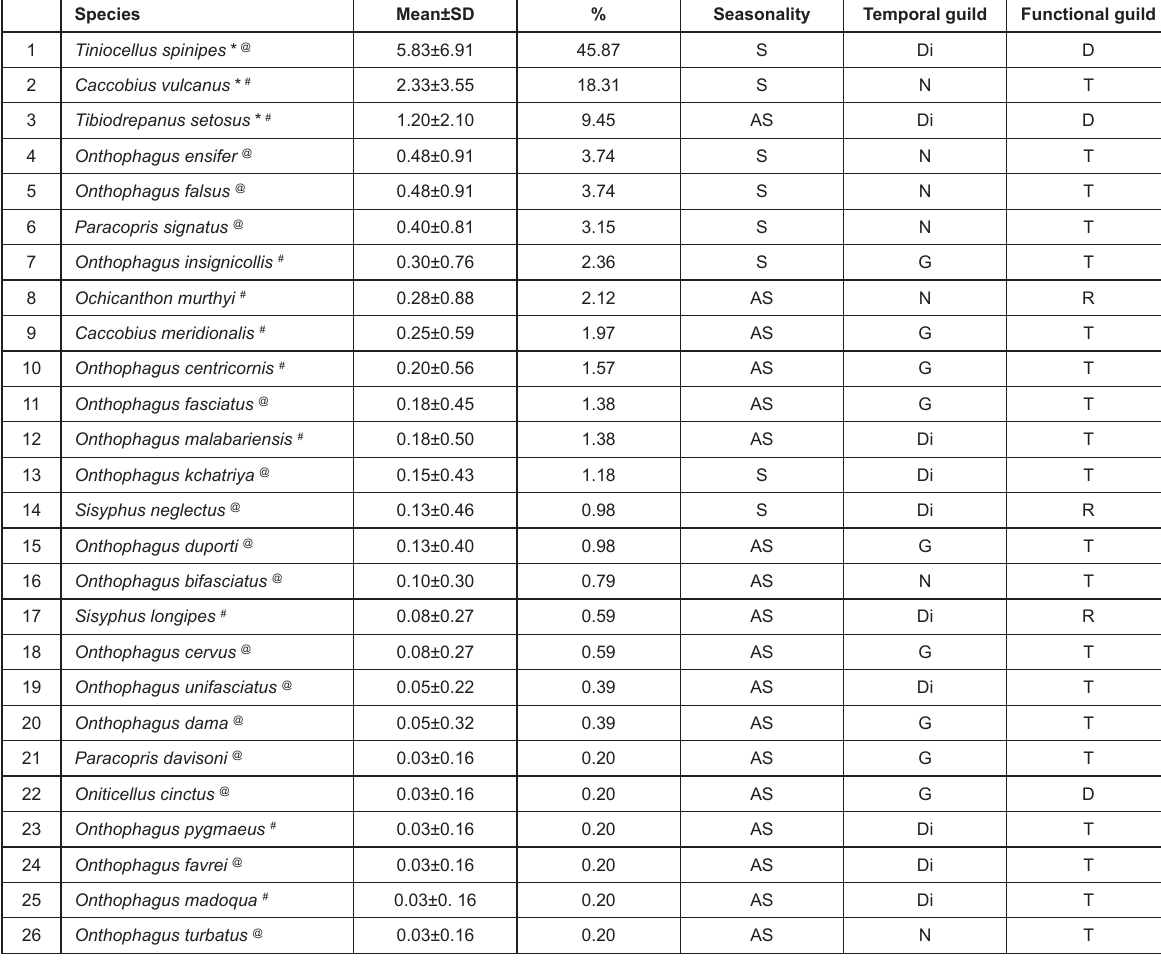
Table 1. Abundance (mean±SD), percentage composition, seasonality, temporal and functional guild of dung beetle assemblage in the fragmented urban agricultural habitat during the 2008–09